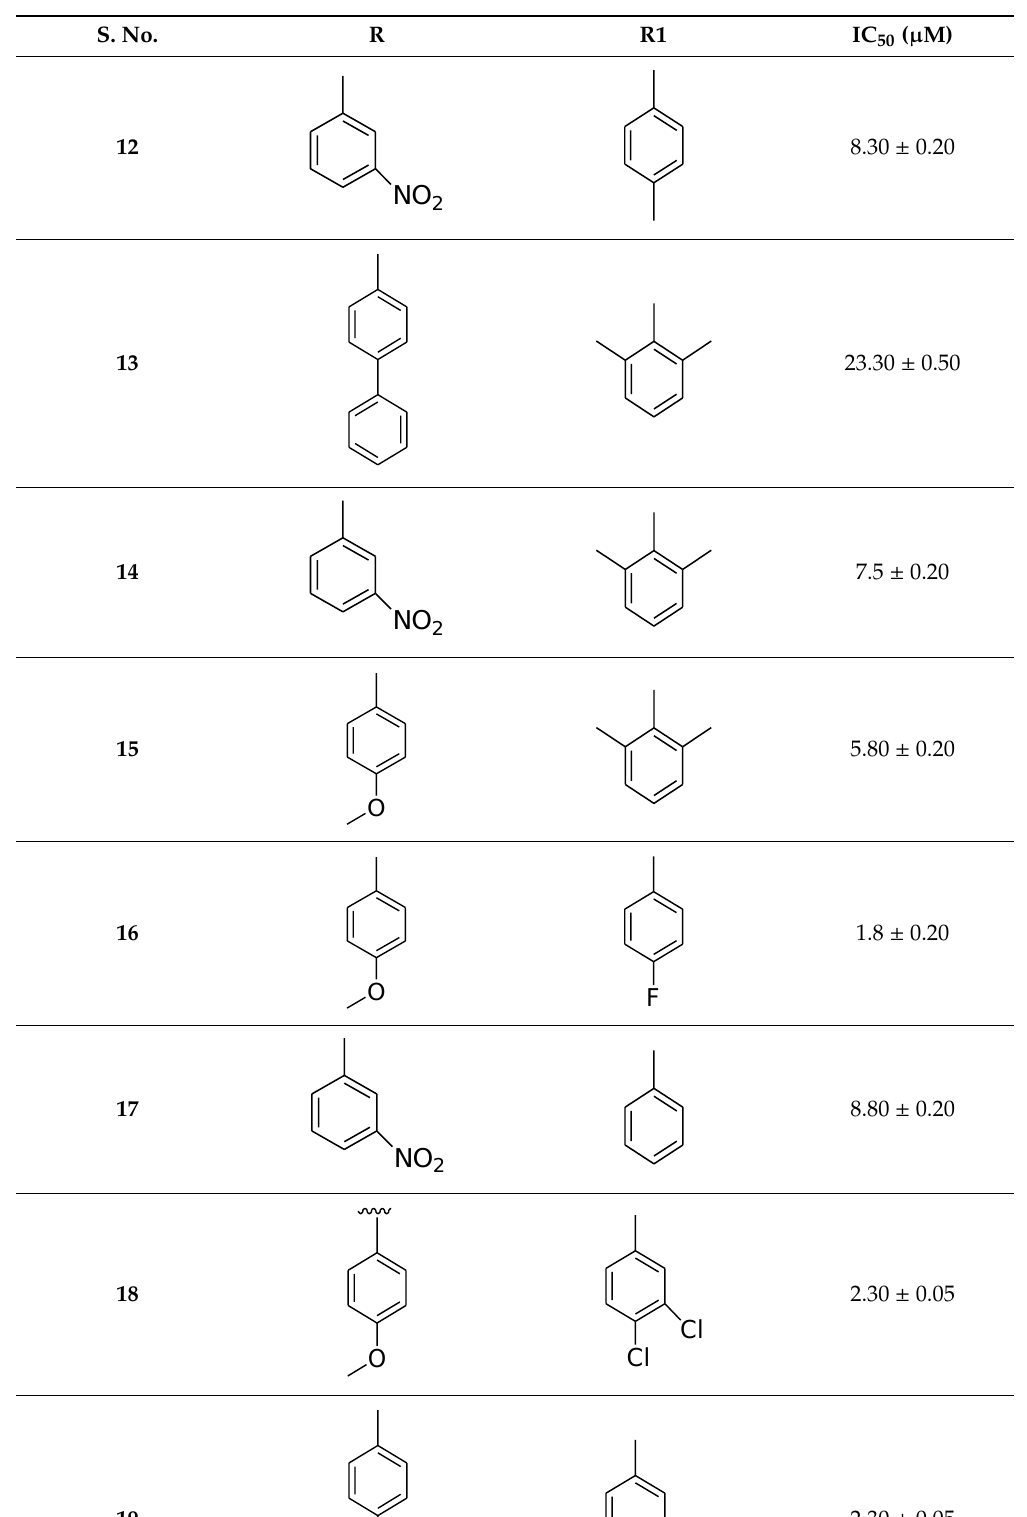
Scheme 2. Synthesis of thiosemicarbazide derivatives.